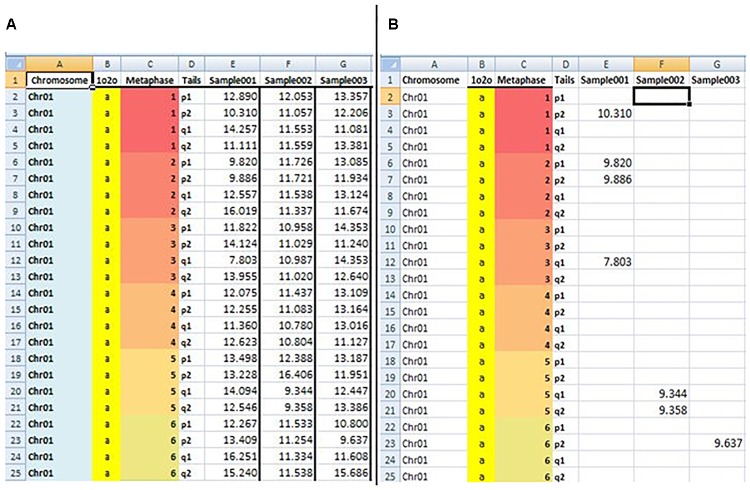
Snapshot of BIOTEL worksheets with estimated raw data of the TL (A) and TLS (TL < 20th percentile) (B). In the (A,B) the first four column address the TL and TLS values by indexing from metaphase, chromsome, pair, and tail. From fifth column onwards values of TL (A) and TLS (B) of an individual were presented.